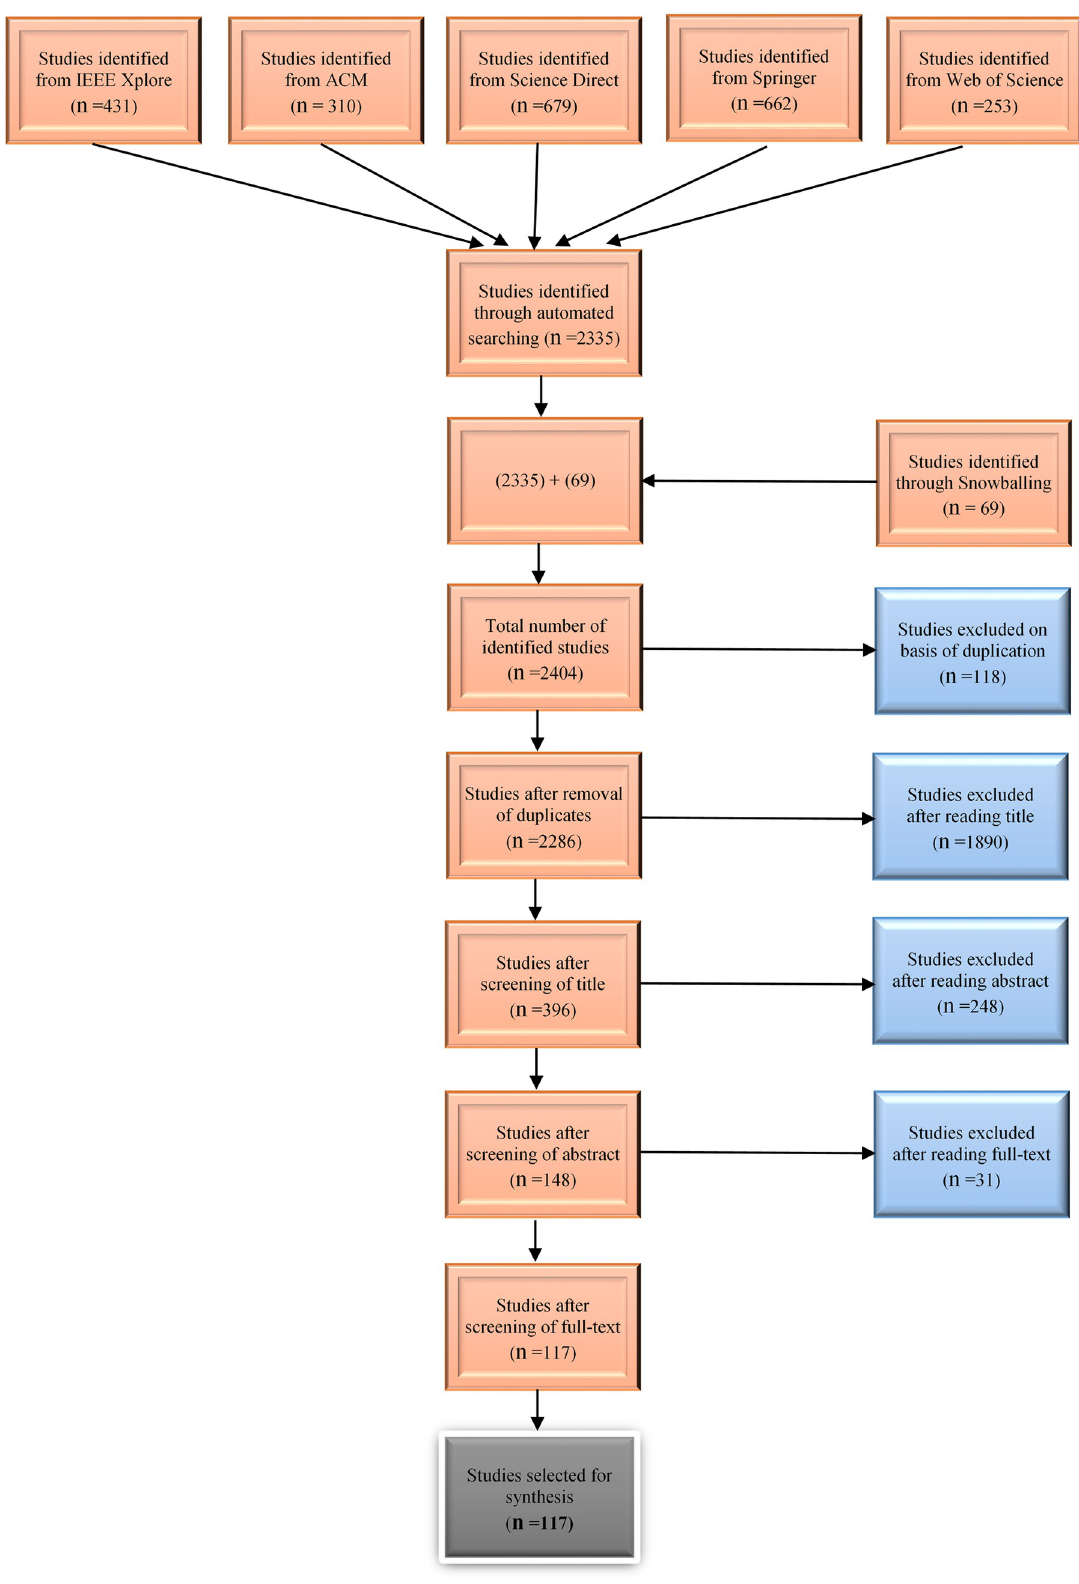
Fig 3. Studies selection